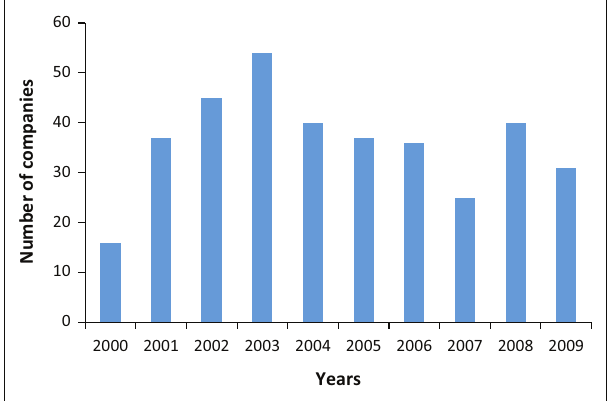
FIGURE 2: Frequency distribution of companies participating in repurchases.